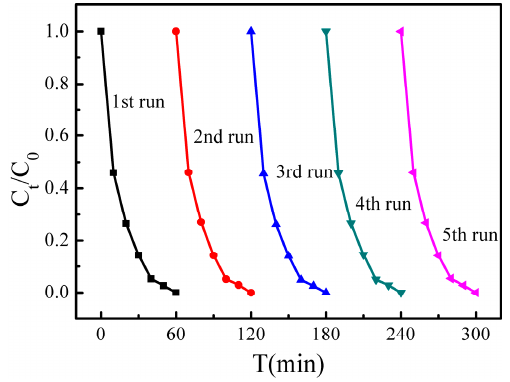
Figure 8. Cyclic photocatalytic degradation experiments of MB by H700 photocatalyst.